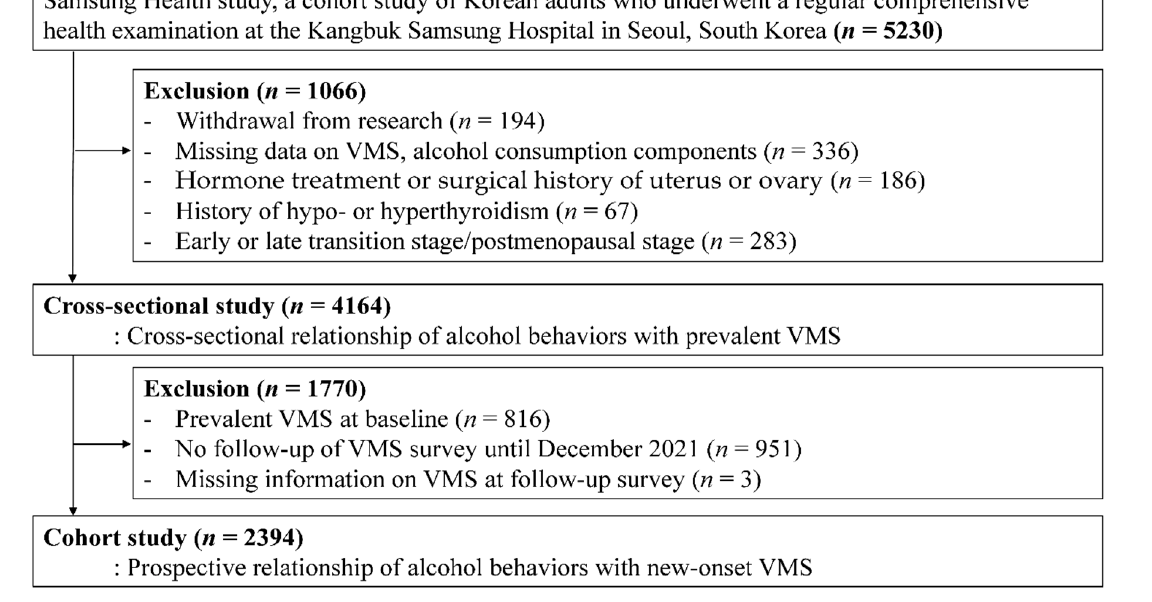
Figure 1. The selection process chart of the participants.